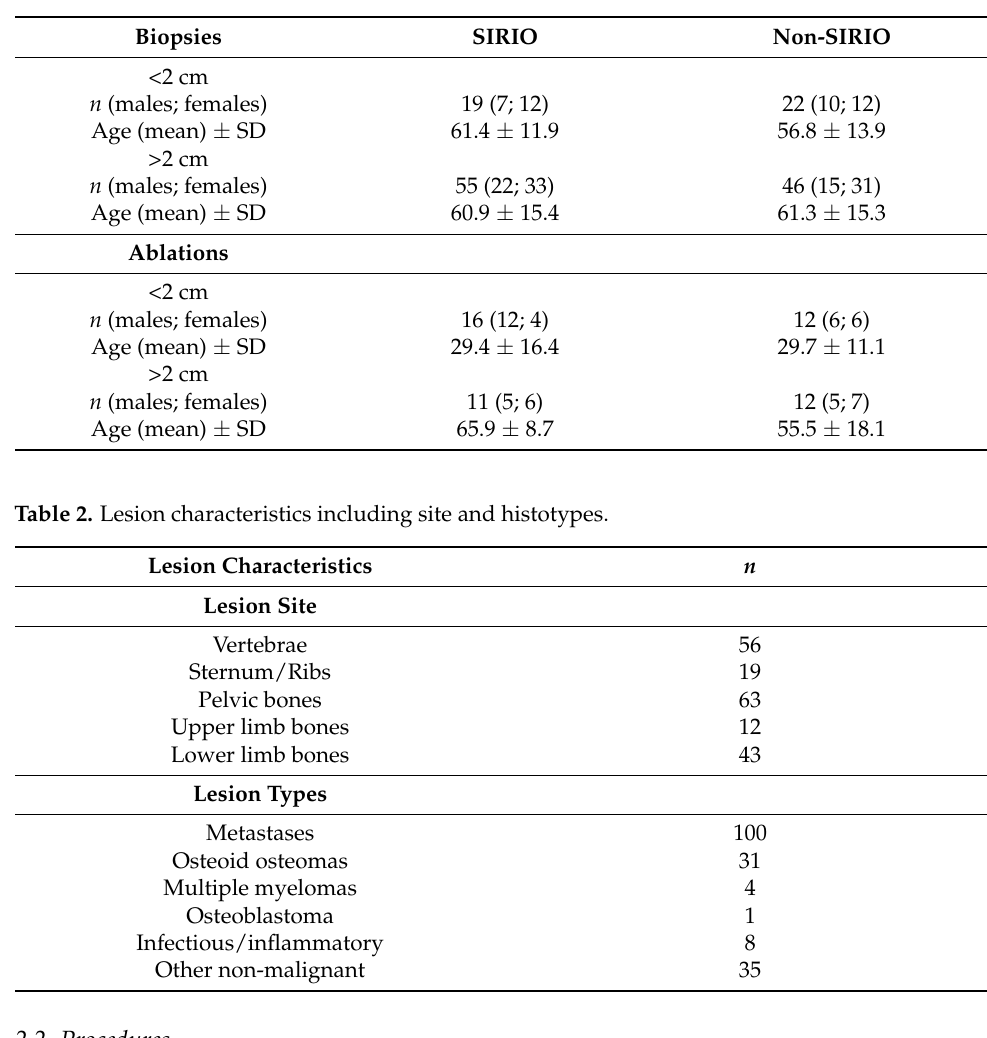
Figure 1. This diagram shows the subdivision of the procedures into the different studied groups, specifying the number of procedures for each group. Table 1. Groups composition with patients’ characteristics; SD = standard deviation.